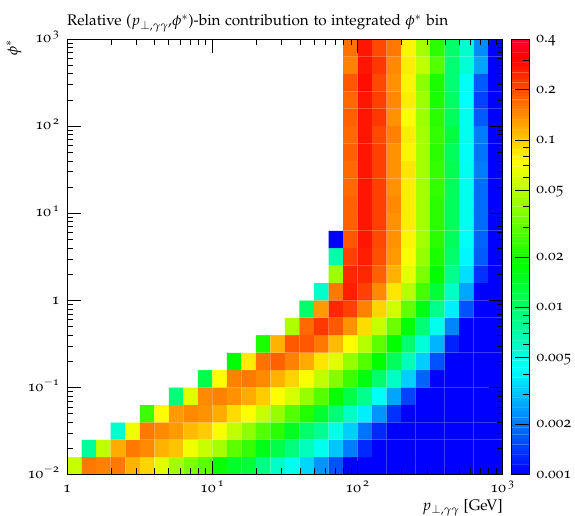
Figure 10 . Correlation between the transverse momentum of the diphoton system and (cid:30) (cid:3) expressed as the fraction each ( p T ;(cid:13)(cid:13) , (cid:30) (cid:3) ) bin contributes to the integrated (cid:30) (cid:3) bin, calculated at LO (cid:13)(cid:13)g , qg (cid:13)(cid:13)q , (cid:22) qg (cid:13)(cid:13) (cid:22) q ) at 13 TeV at the LHC. The photon acceptance accuracy (using q (cid:22) q ! ! ! cuts of eqs. (3.1) and (3.3) are applied, but no jet is required.